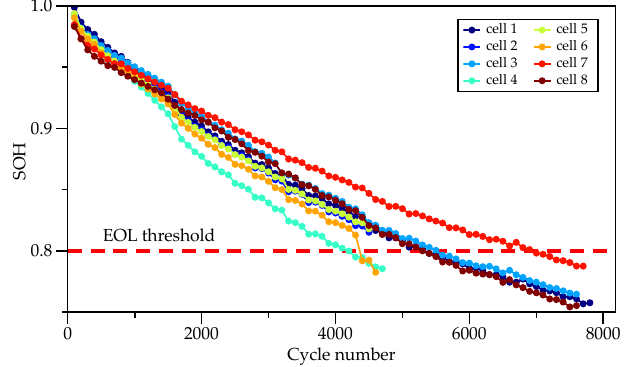
Figure 3. SOH curves of cell 1 to cell 8.